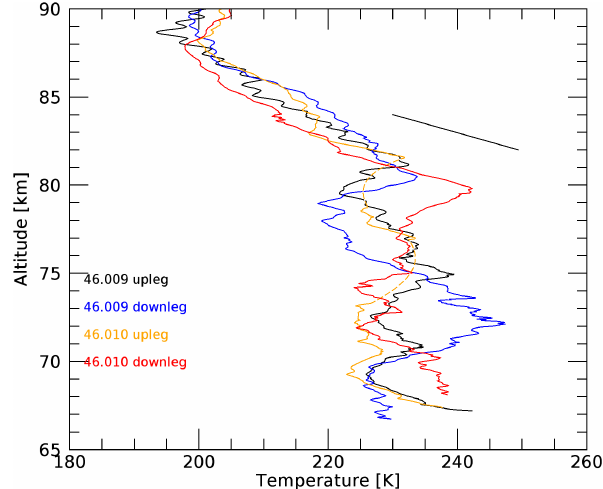
Figure 8. Detail of temperature profiles in the lower mesosphere. Same data as in Fig. 7, but unfiltered to emphasize fine structure. The regular modulations above 80km in the black profile are due to the payload